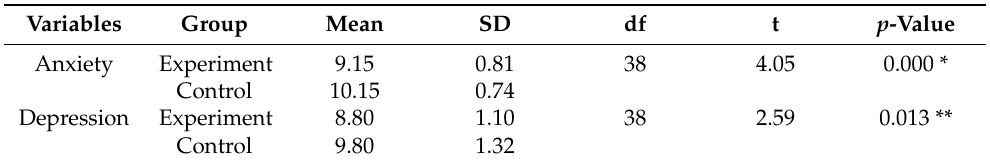
Table 5. Comparisons of anxiety and depression scores after intervention between experimental and control groups (N =